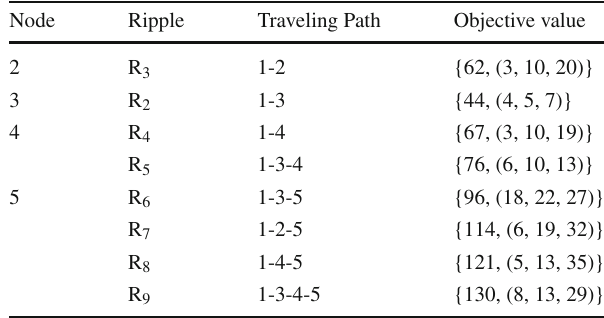
Table 3 All PORs at each node after solving Example 1